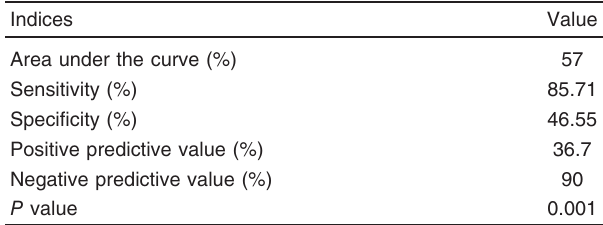
Table 3 Diagnostic indices of the computed tomography- attenuation value in determining the nature of effusion